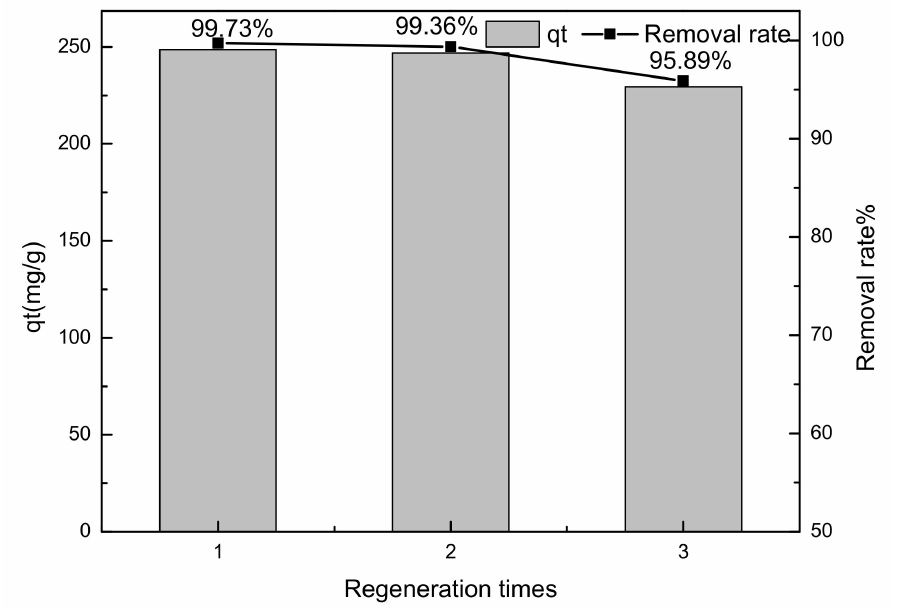
Figure 14. Influence of regeneration cycle on the adsorption of sulfonated lignite by filter paper- templated Mg-Al metal oxides (initial sulfonated lignite concentration: 200 mg/L; adsorbent dosage: 0.015; initial pH: 7; temperature set to 25 ◦ C; stirring time: 12